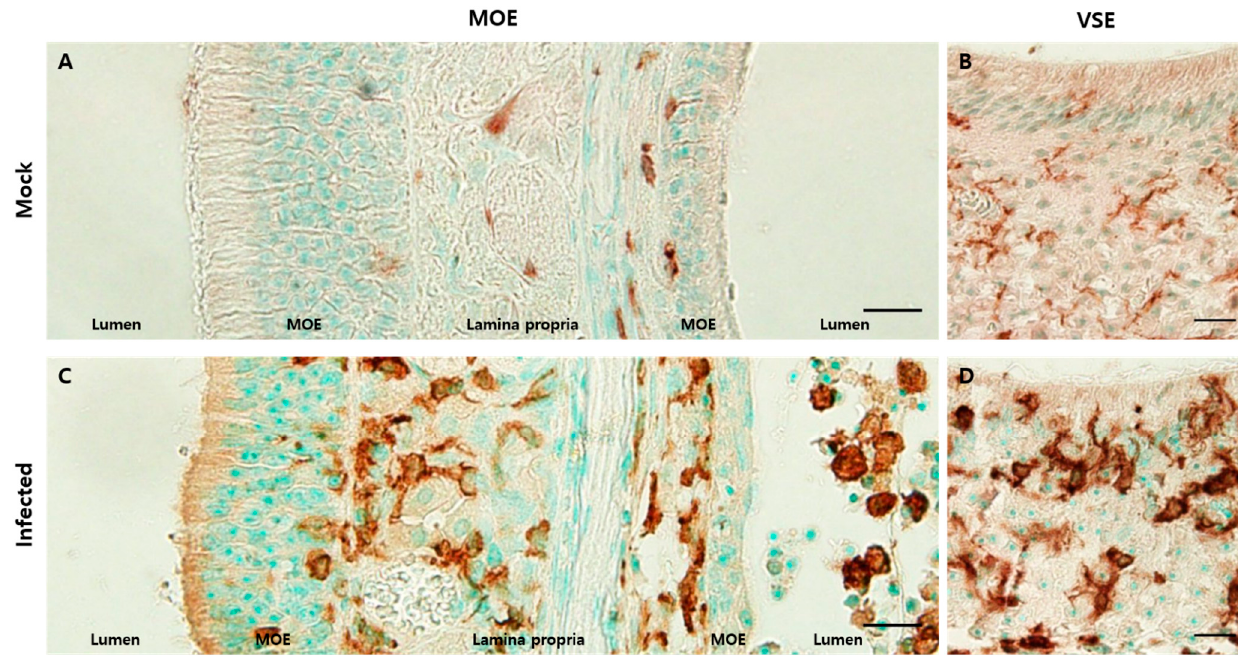
Figure 6. Inflammatory cells infiltrated olfactory structures. Scale bars = 20 μ m. ( A ) DAB staining with the antibody against Iba1 in the MOE of the mock group. Iba1-positive cells were mostly present in the lamina propria and some were adjacent to the basal lamina; ( B ) DAB staining with the antibody to Iba1 in the VSE of the mock group. Iba1-positive cells showed their processes, which meant that they were in a resting state; ( C ) DAB staining with the antibody against Iba1 in the MOE of the infected group. There were increased Iba1-positive cell levels. These cells were located in the lamina propria, a relatively superficial portion of the epithelia, and the lumen; ( D ) DAB staining with the antibody to Iba1 in the VSE of the infected group. Many Iba1-positive cells were amoeboid in shape and more densely stained. They were in an active state.